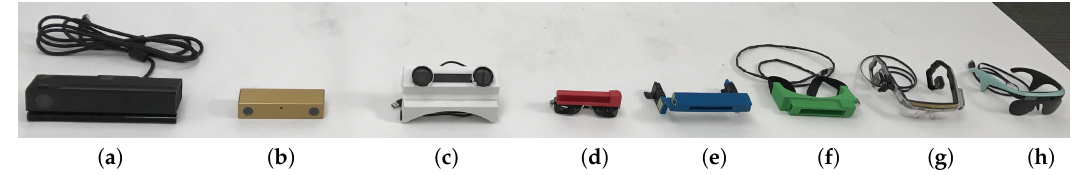
Figure 15. Evolution of the smart glasses: ( a ) Kinect used in [20,43], ( b ) Bumblebee stereo camera used in [9,10], ( c ) pRGB-D sensor [41], ( d ) a pair of sunglasses with sensors [13], ( e ) a 3D-printed prototype with RGB-D sensor and millimeter wave radar, ( f ) a 3D-printed prototype with RGB-D sensor and IMU [22], ( g ) a wearable navigation system [81] and ( h ) the pair of smart glasses that has been made available at